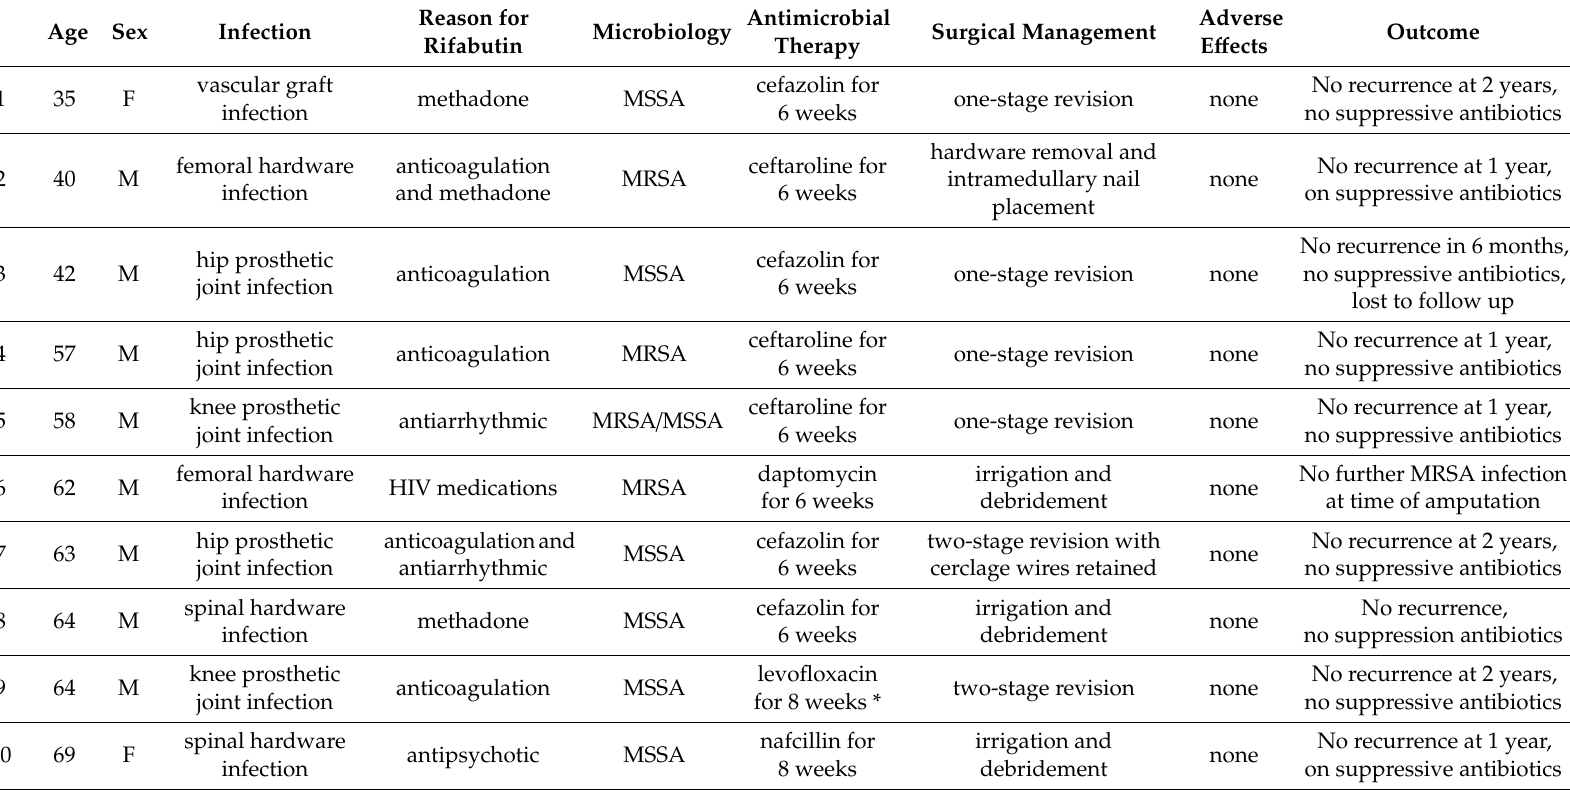
Table 1. Patients who received rifabutin for staphylococcal